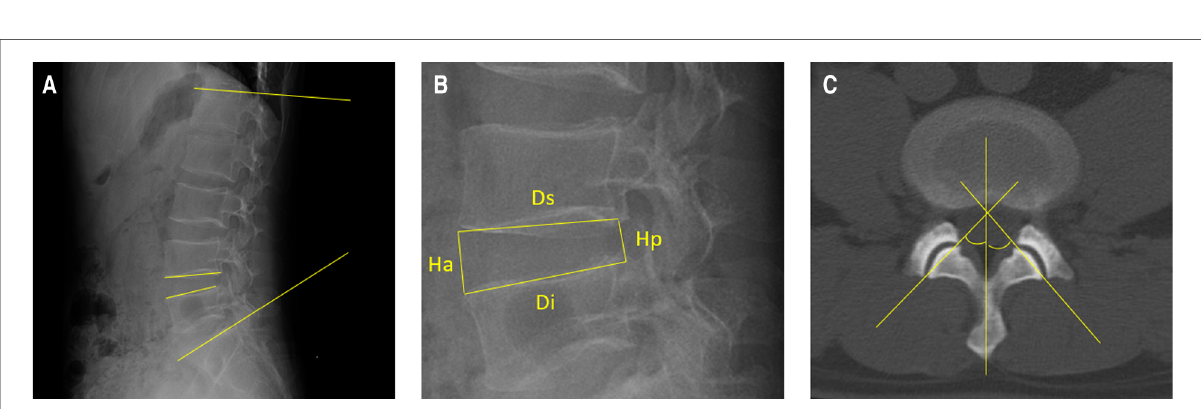
FIGURE 2 Illustration of the measurements of the radiological parameters. ( A ) Lumbar lordosis is de fi ned as the angle between the superior endplates of L1 and S1. The disc wedging angle is de fi ned as the angle between the lower endplate of the upper vertebra and the upper endplate of the lower vertebra. Additionally, the sagittal range of motion is de fi ned as the absolute difference between the disc wedging angles in fl exion and extension positions. ( B ) Disc height index is calculated with the equation: [(anterior disc height+posterior disc height)/(superior disc depth+inferior disc depth)]×100. ( C ) A line is drawn to connect the anterior and posterior margins of the superior articular process. The other line represents the midsagittal line. The facet orientationis calculated asthe mean of the facet angle between the right and left sides. The facet tropism isthe absolute difference between the two sides.